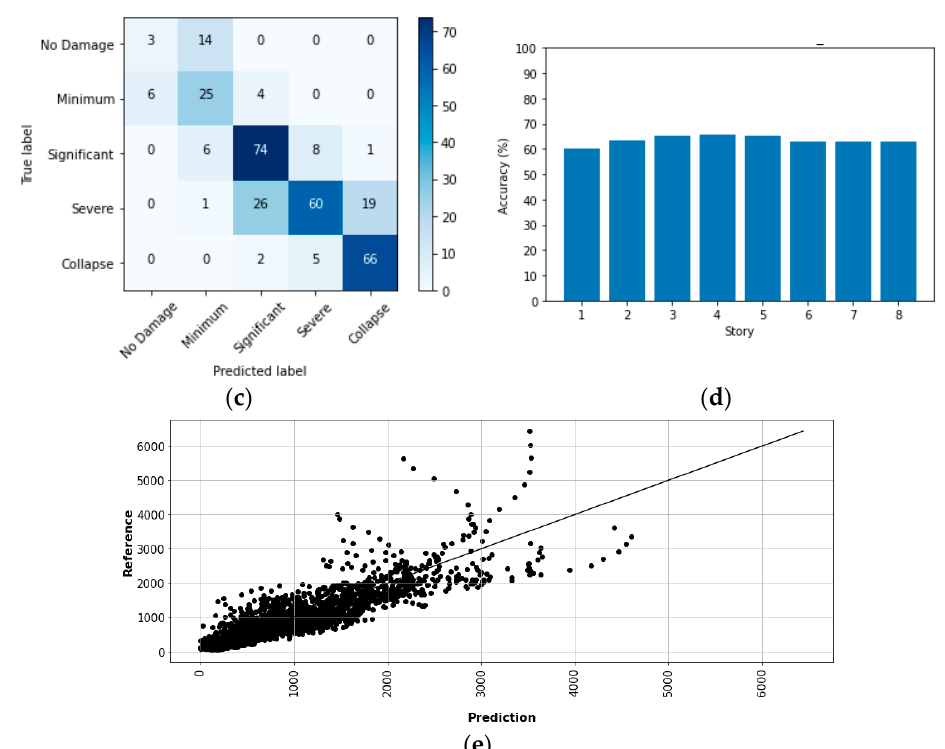
Figure 20. AA results of the TP and VP for Toyohashi Fire Station building: ( a ) convergence curve—loss in the TP; ( b ) confusion matrix—usability of the building by VP; ( c ) confusion matrix—total damage condition by VP; ( d ) confusion matrix—storey damage condition by VP; ( e ) total comparison of AA.